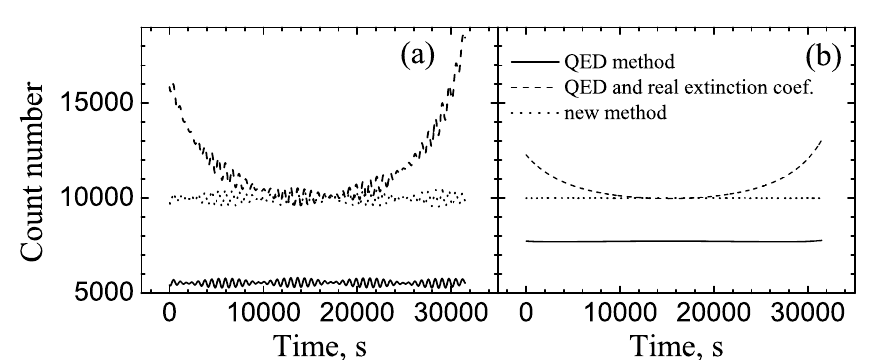
Fig. 7. The reduced synthetic observations of the program star O V (a) and of the comparison star G0 V (b). For the reduction the following extinction coefficients are used: the solid curve – the extinction coefficients are determined by the QED program methods (Case I), taking α (OV) = 0.98 mag and α (G0V) = 0.645 mag; the dashed curve – real extinction co- efficients are determined by the QED program (Case II), taking α (OV) = 1.607 mag and α (G0V) = 0.915 mag; the dotted curve – the extinction coefficients are calculated by the new method using synthetic photometry (Case